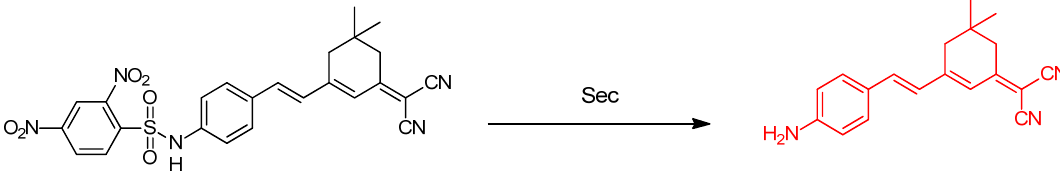
Figure 2. Structure of the Sec probe reported by Zhang et al. and its